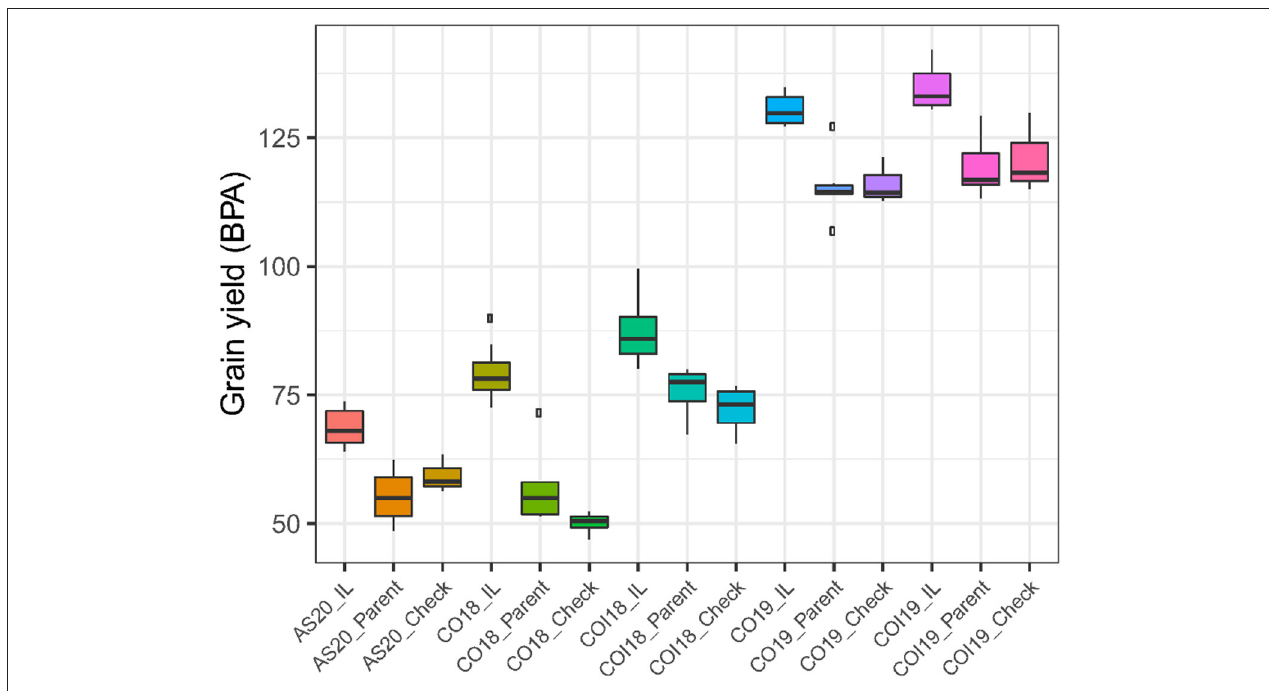
FIGURE 1 | Boxplots comparing the mean grain yield (GY) between the top-performing introgression lines (ILs) and the controls (parents and checks) across treatments, years, and locations. AS20 refers to Ashland rainfed trial in 2020, CO18 is Colby rainfed trial in 2018, COI18 is Colby irrigated trial in 2018, CO19 is Colby rainfed trial in 2019, and COI19 is Colby irrigated trial in 2019.